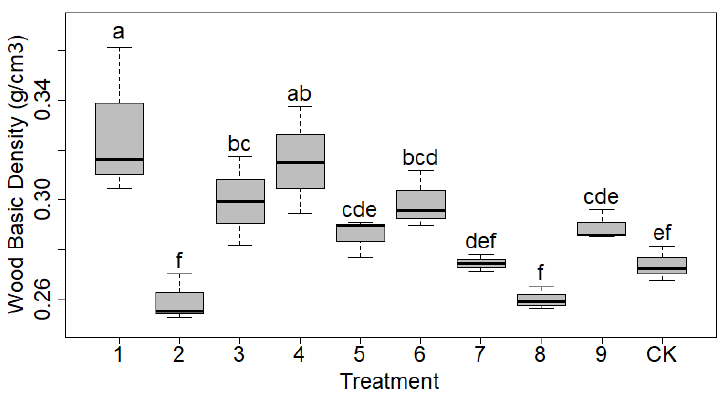
Figure 3. Variance analysis of the wood basic density of dyed red-heart Chinese fir with different dyeing treatments. The same lowercase letters indicate no significant difference.